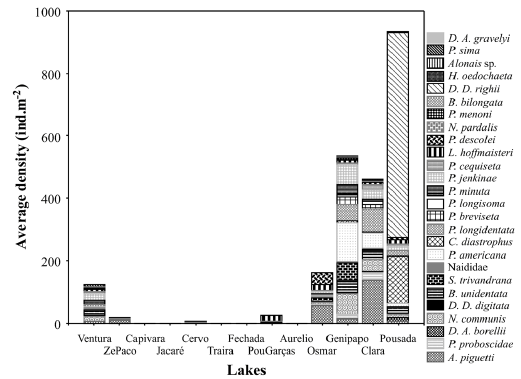
Figure 2. Mean densities of Oligochaeta species in each floodplain